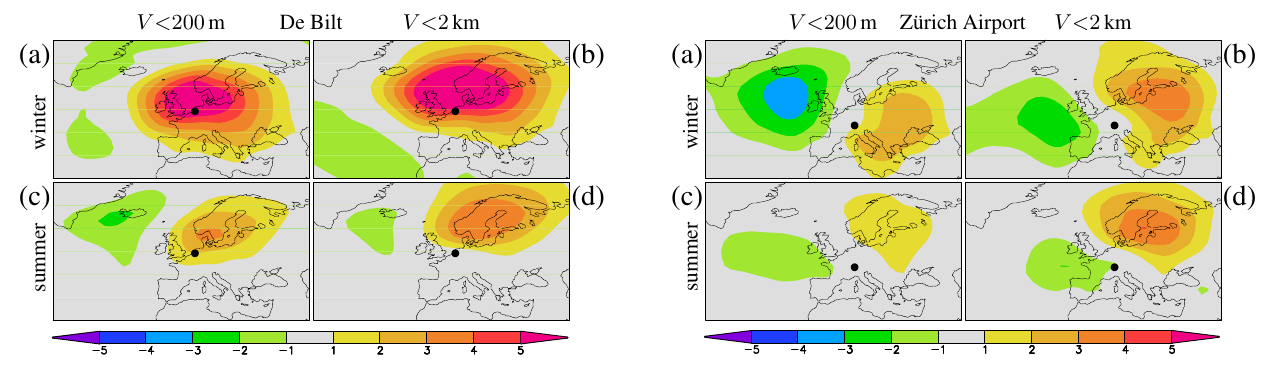
Fig. 7. As Fig. 6 but for Z¨urich Airport.